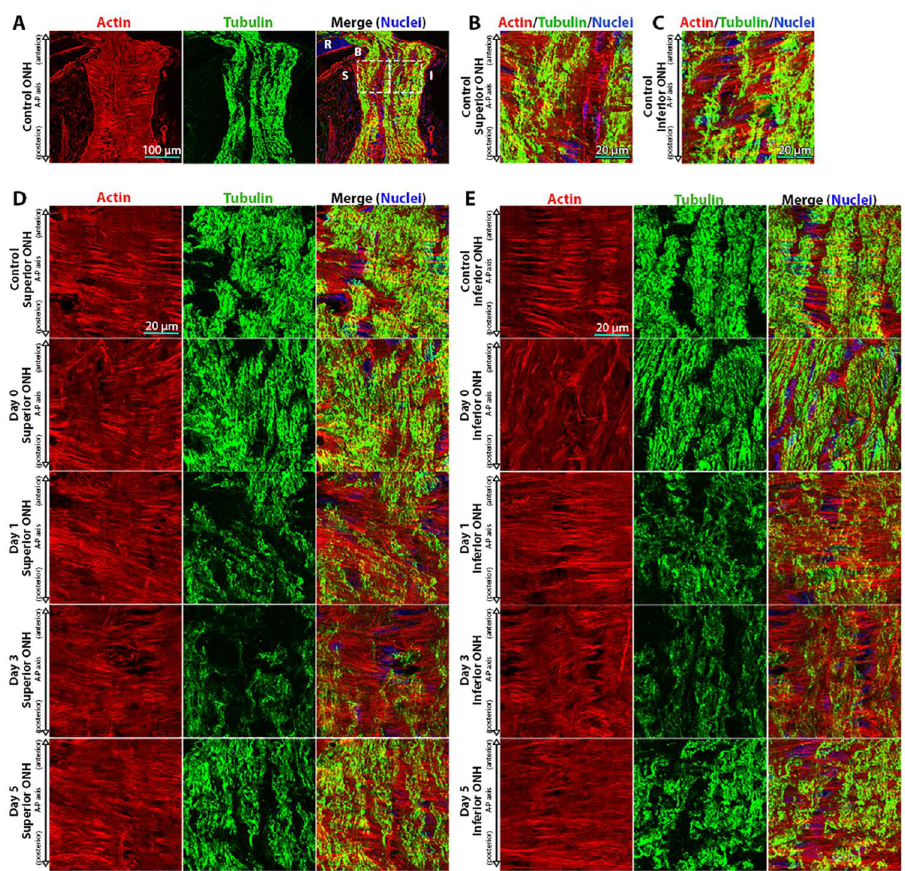
Fig 1. Actin-based astrocyte extensions change orientation within hours after intraocular pressure elevation. (A) Low magnification images of control optic nerve head (ONH) sectionslabeledfor actin (TRITC- phalloidin), tubulin (Tuj1 anti-tubulin β III antibody),and nuclei (DAPI). The left and right boxes in the merged image indicate the anterior superior and inferior regions of the ONH, respectively.(B, C) High magnification images of the superior and inferior regionsof the ONH, as indicatedby boxes in panel (A). Representative superior (D) and inferior (E) ONH regions from control eyes and eyes exposed to 8 hours of intraocular pressure(IOP) elevation, labeledfor actin, tubulin, and nuclei. Day 0 eyes were immediately fixed after 8 hours of IOP elevation, whileday 1–5 indicatethe periodof time the IOP was normalizedpost IOP elevation prior to fixation. A-P = anterior-posterior, B = Bruch’s membrane, I = inferior, R = retina, and S =